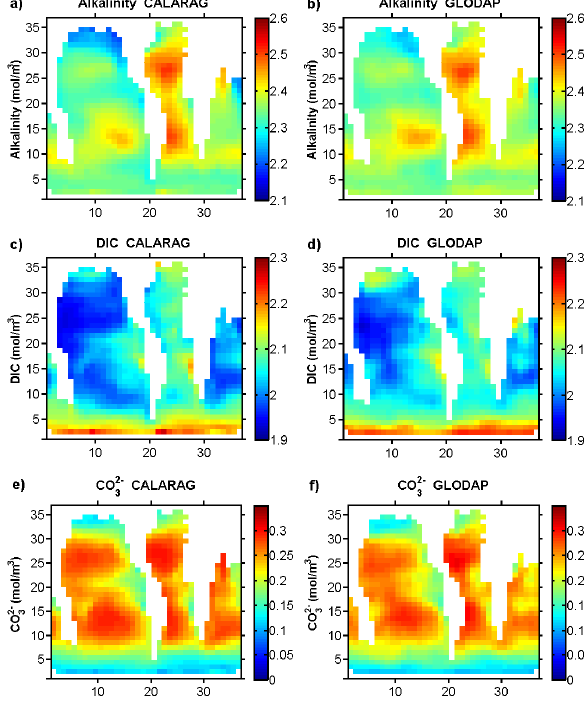
Fig. 8. Distribution of (a, b) alkalinity, (c, d) DIC and (e, f) car- bonate ion concentrations simulated by the Bern3D/PISCES model (left) and from the GLODAP data (right; Key et al., 2004). Values are from the model version CALARAG that represents calcite and aragonite production and shown are averages over the top 3 layers of the model, equivalent to a depth of